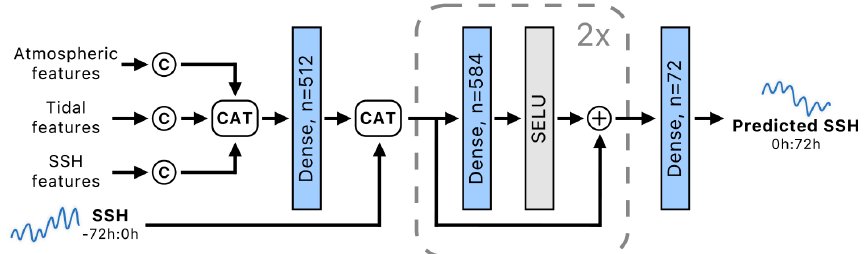
Figure 7. The fusion-regression block firstly re-calibrates the features (the C symbol), and then concatenated features are passed to a dense layer, which fuses features and reduces their dimensionality. Undistorted SSH is appended and processed with two residual blocks. The final dense layer outputs the predictions. The variable n denotes the number of output